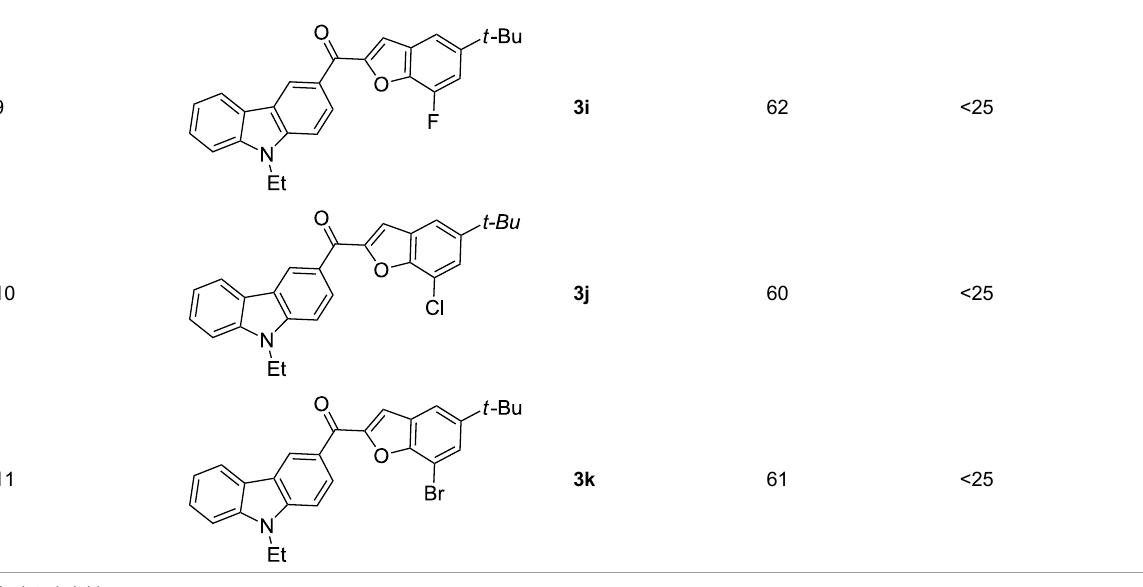
Table 1: Synthesis of 3-(2-benzofuroyl)carbazole derivatives ( 3a – k ).